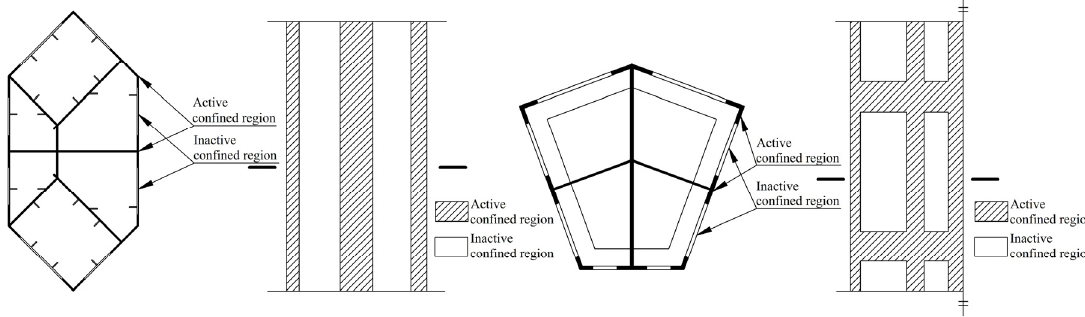
Figure 1. Division of confined regions of special ‐ shaped concrete filled steel tube (CFT) column with multiple cavities.